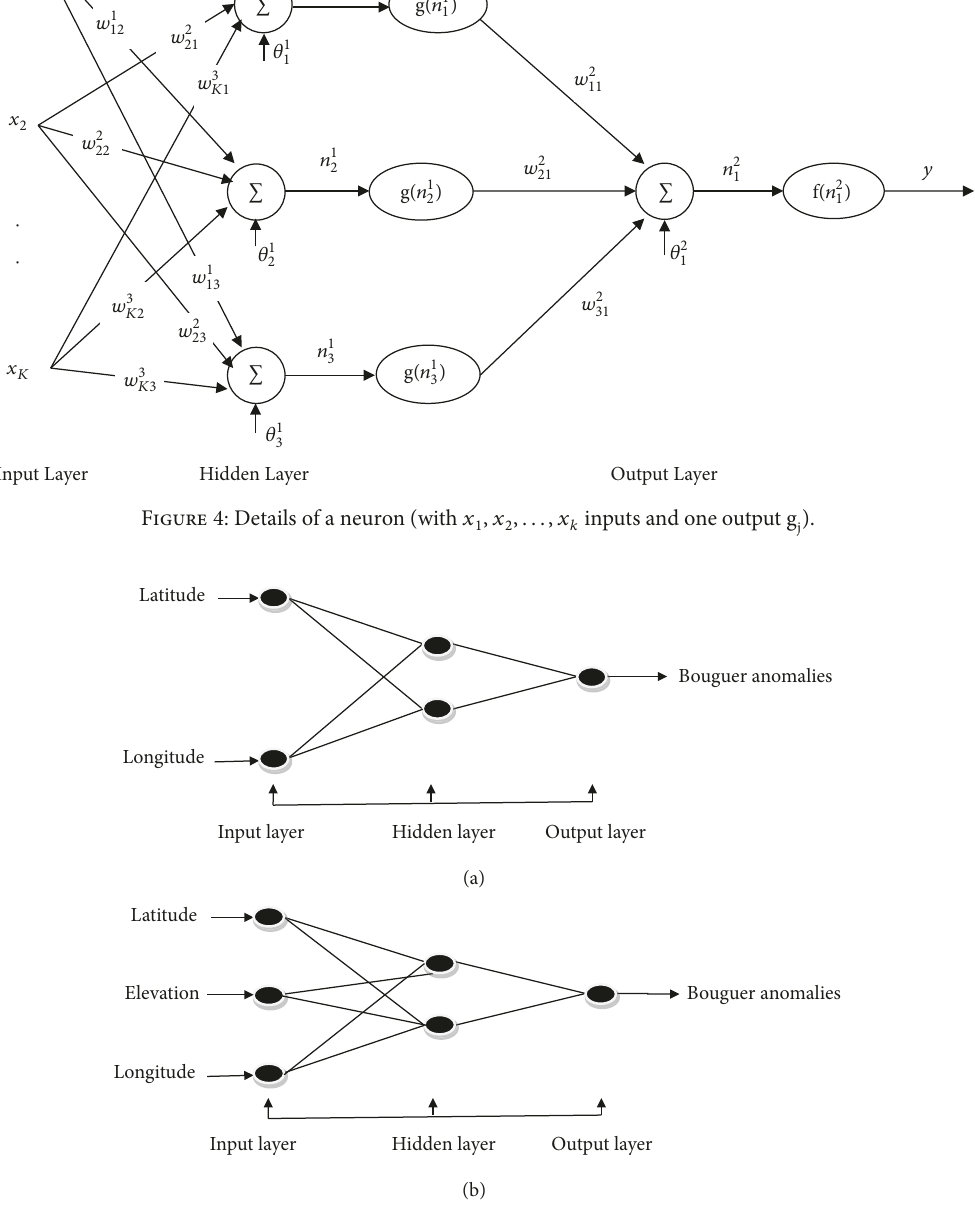
Figure 5: Multilayered Perceptron (MLP) network for (a) 2 inputs and (b) 3